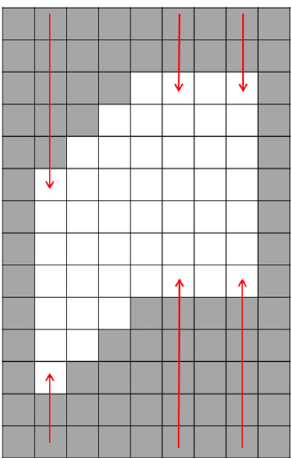
Figure 6. Schematic of the secondary adaptive image processing area.